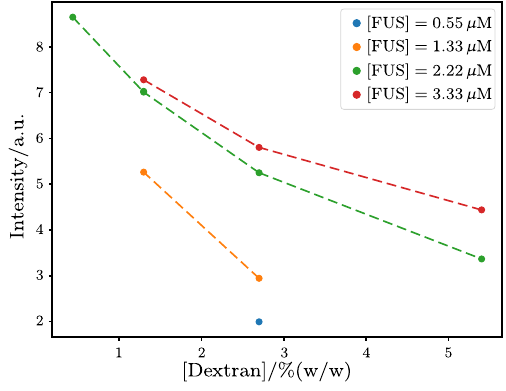
FIG. 7. Full linescan data for the FUS-dextran